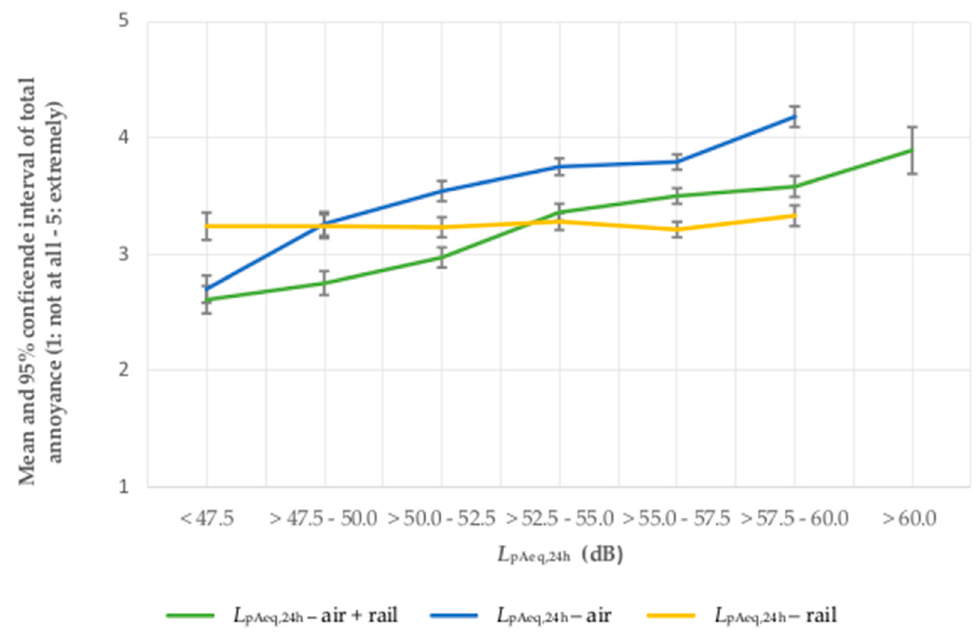
Figure 3. Total noise annoyance by aircraft + road traffic, aircraft and road traffic noise in association with the 24 ‐ h average sound pressure level, L pAeq,24h of aircraft + road traffic, aircraft and road traffic noise.